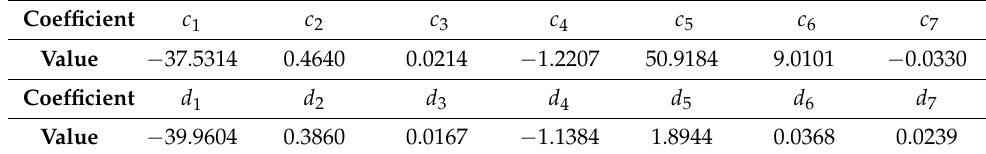
Table 9. The coefficients in Equation (17).